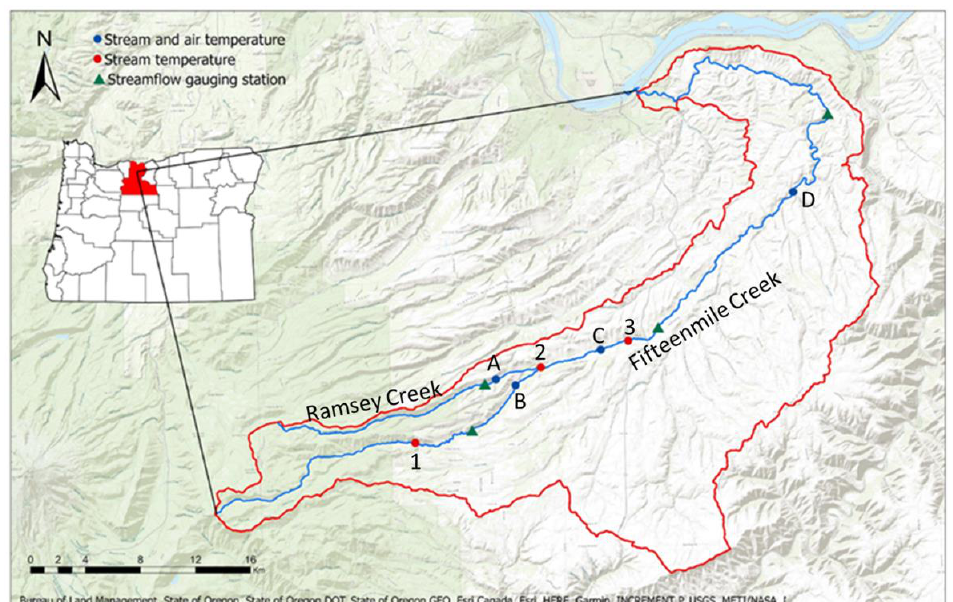
Figure 3. Map of the 15-MC study area showing streamflow gauging stations and stream and air temperature monitoring locations. The 15-MC HUC-10 watershed is outlined in red. Locations of the riparian stream study sensors are labeled in order of decreasing elevation: Ramsey Creek valley site (A), the 15-MC upstream site (B), the 15-MC valley site (C), and the 15-MC downstream site (D). Red circles indicate locations of stream temperature sensors used courtesy of the Oregon Department of Fish and Wildlife (ODFW): 15-MC upstream (1), Ramsey Creek (2), and 15-MC valley (3).